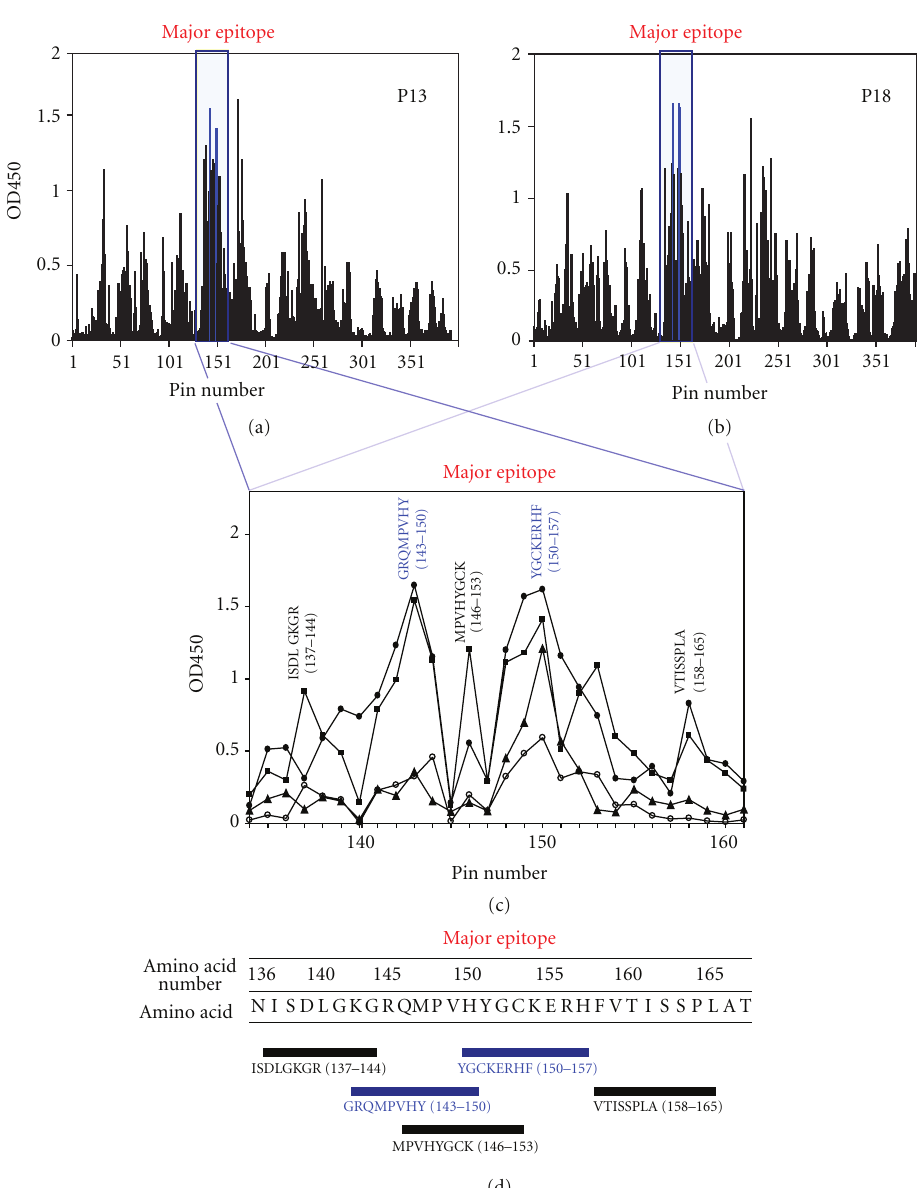
Figure 2: Reactivities of PBC sera against synthesized overlapping peptides of BCOADC-E1 α . (a) and (b) Pin ELISA profiles of PBC sera. The reactivities of two high-titer PBC sera (P13 and P18) against the peptides were analyzed by pin ELISA. The location of the major epitope (region 6) is indicated by the blue squares. The two peptides showing the highest OD450 values are also highlighted in blue. (c) Clustering of small epitopes in the major determinant region. In the major determinant region (blue square), which corresponds to the blue squares in (a) and (b), multiple small epitopes are present as shown by the multiple peaks in the ELISA profiles. The reactivities of PBC sera against (cid:2) , P20). The two octapeptides showing the highest values in (a) and (b) are highlighted in the peptides are shown ( (cid:4) , P07; (cid:2) , P13; • , P18; blue. (d) Overlapping epitopes are clustered in the major determinant region. The sequences of the octapeptides that exhibited peaks in (c) are indicated. The two octapeptides with the highest values in (c) are highlighted in